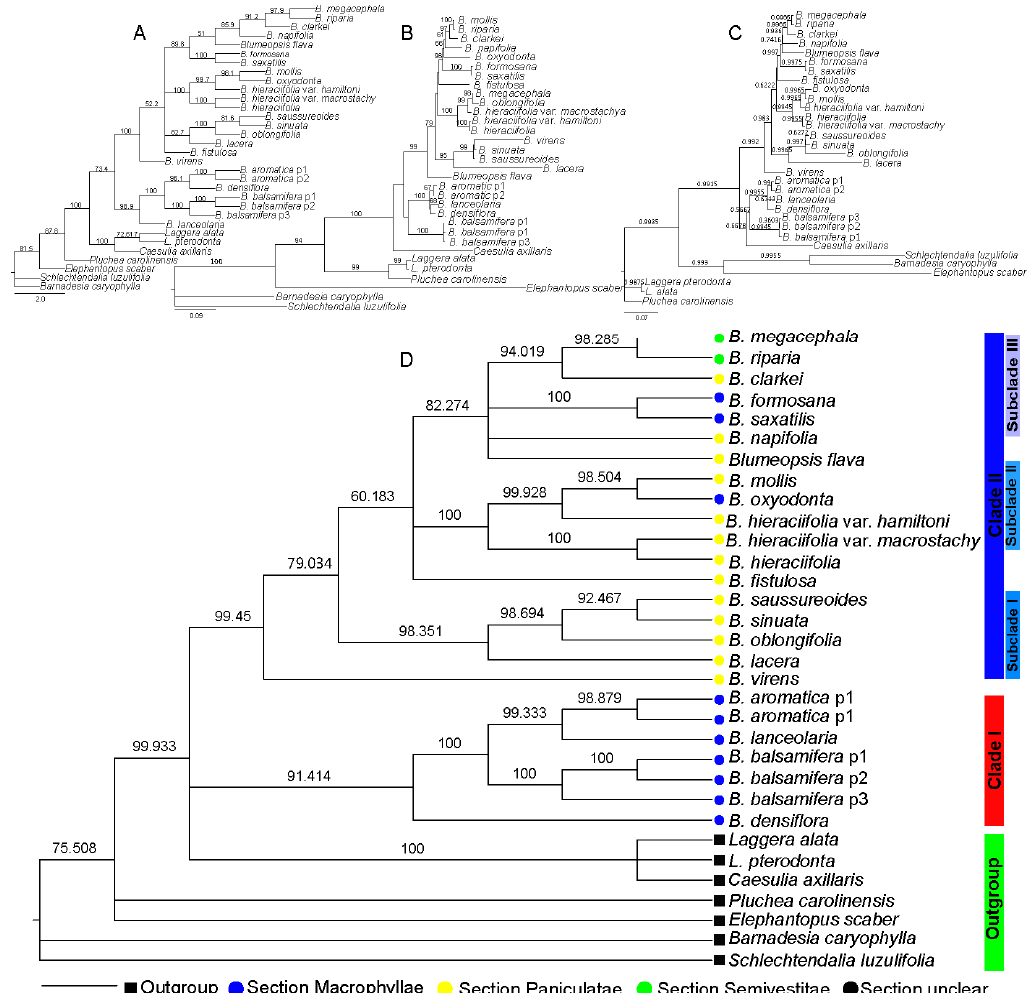
Figure 1. Phylogenetic tree based on the nrDNA internal transcribed spacer (ITS) sequence, where the numbers above the branches indicate the bootstrap value or posterior probabilities. ( A ) Phylogenetic tree determined by Neighbor-joining (NJ) method using the PAUP program; the numbers above the branches indicate the bootstrap value. ( B ) Phylogenetic tree with best topology, determined by Maximum Parsimony (MP) method using the PAUP program. The numbers above the branches indicate the bootstrap value. ( C ) Phylogenetic tree determined by Bayesian inference (BI) method using the MrBayes program; the numbers above the branches indicate the posterior probabilities. ( D ) Phylogenetic tree determined by Maximum Likelihood (ML) method using the IQtree program; the numbers above the branches indicate the bootstrap value.